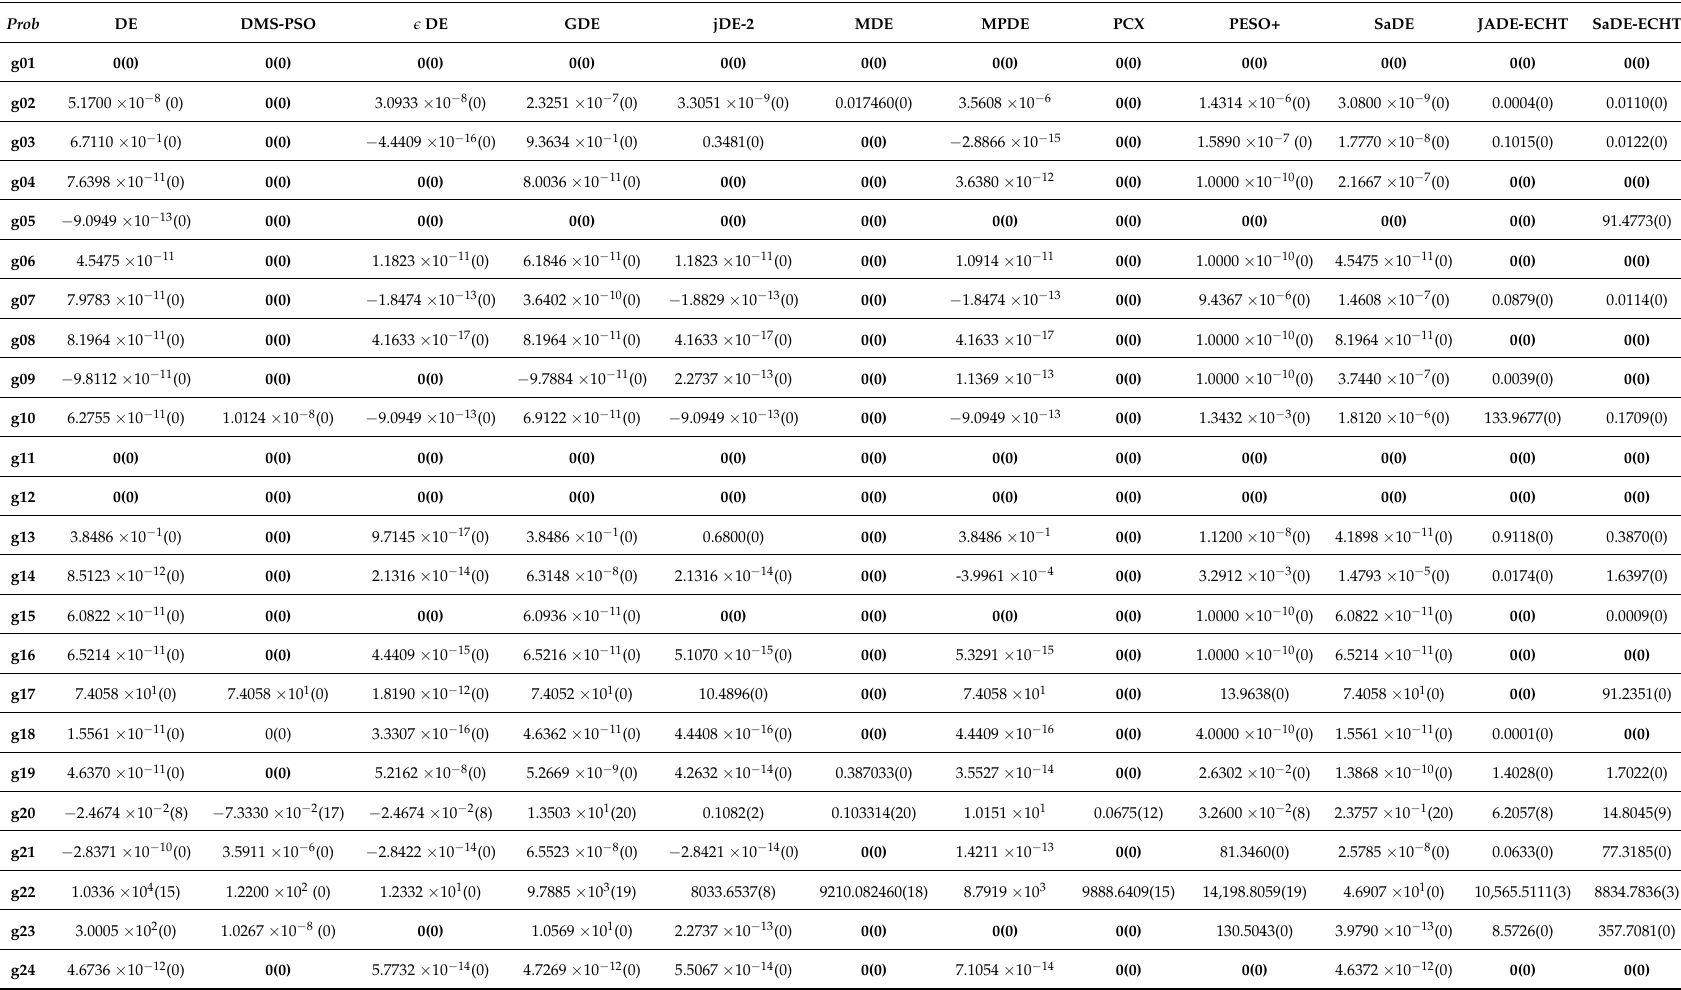
Table 8. Comparison of median values of JADE-ECHT, SaDE-ECHT and CEC’2006 algorithms achieved after 500,000 FEs. The bold numbers indicate the better